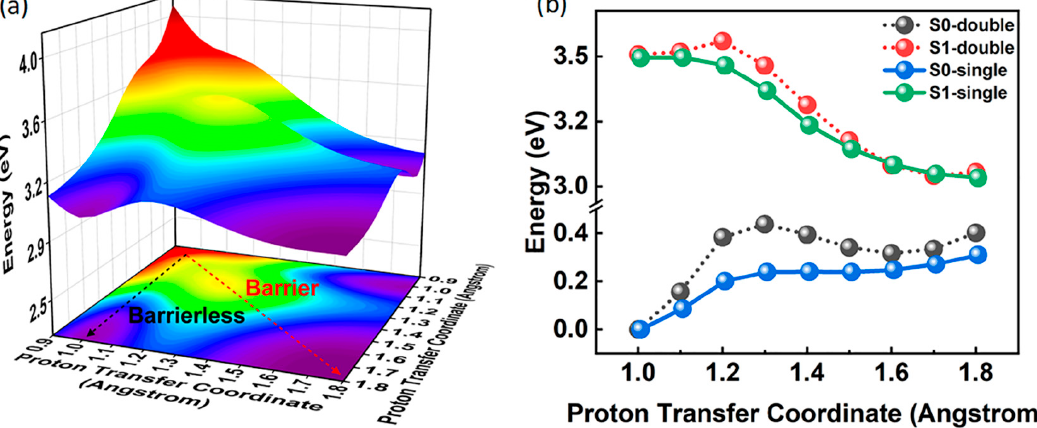
Figure 4. Constructed ( a ) PES in the S 1 state and ( b ) PECs in the S 0 and S 1 states for BP(OH) 2.